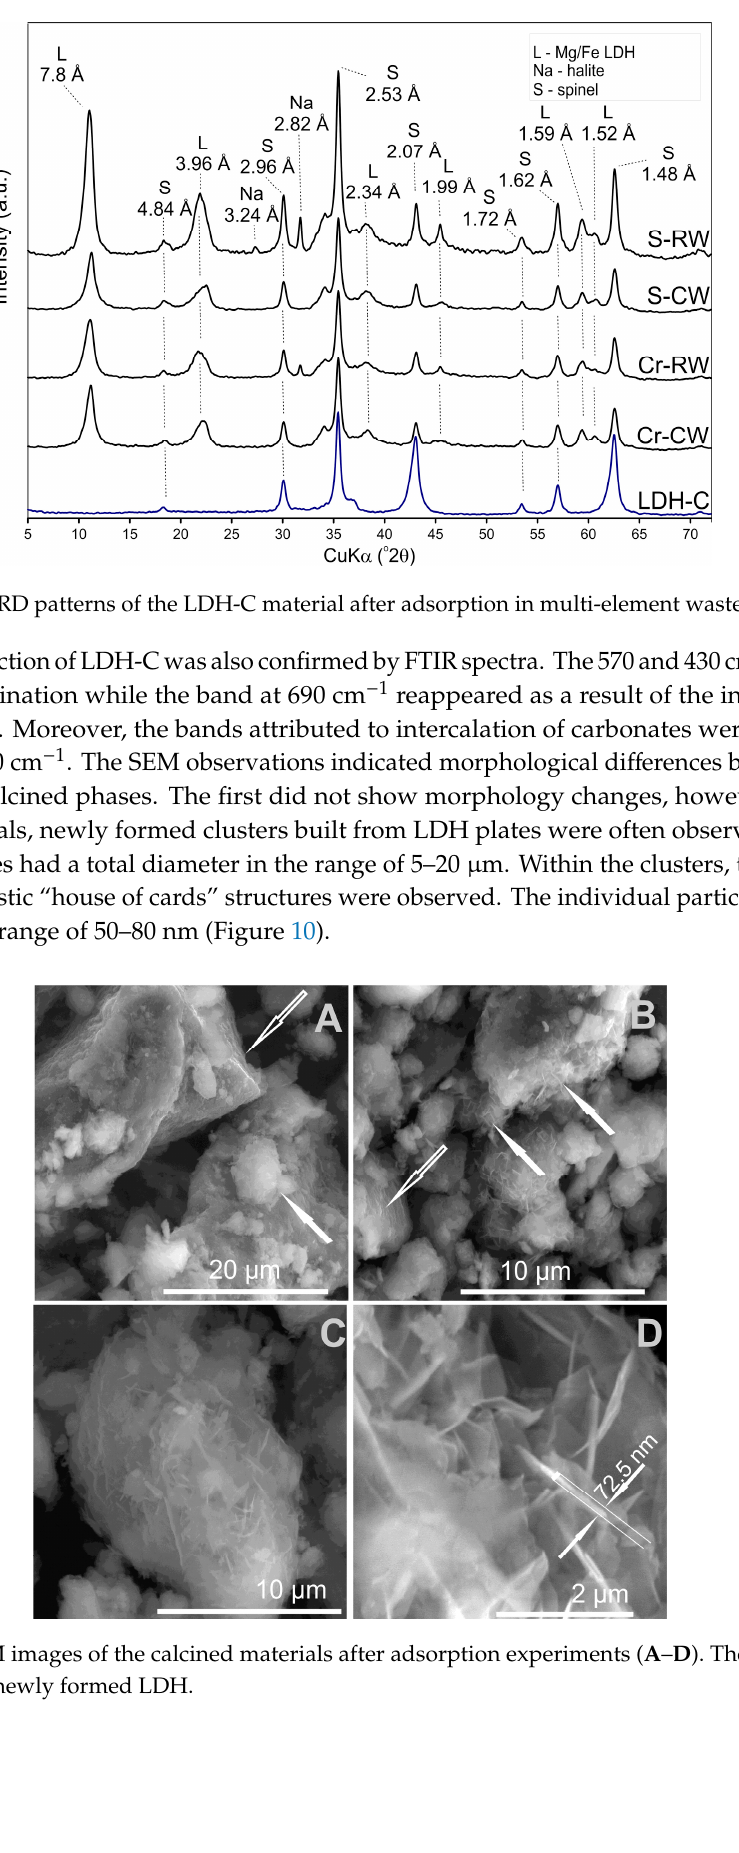
Figure 10. SEM images of the calcined materials after adsorption experiments ( A-D) . The arrows in ( A ) and ( B ) indicate newly formed LDH. ( A , B ) indicate newly formed